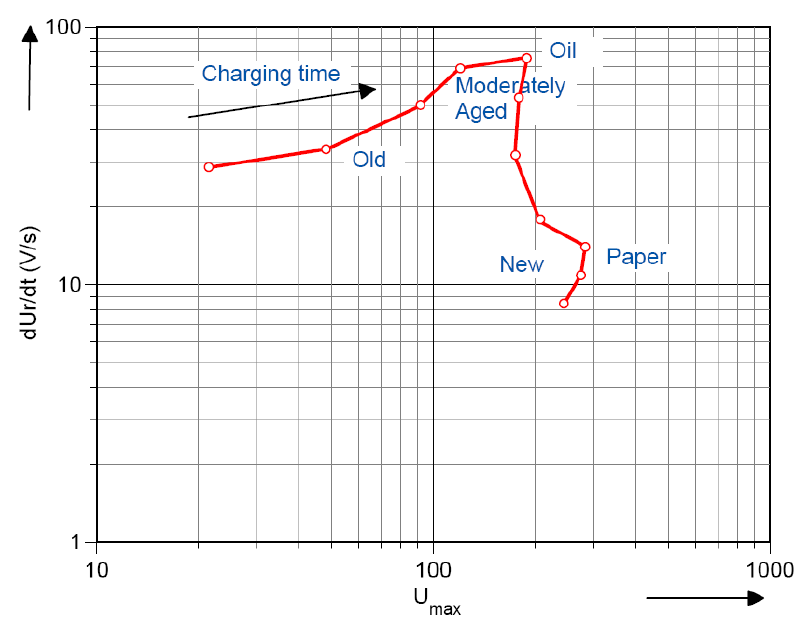
Figure 4. Guuinic representation [121].